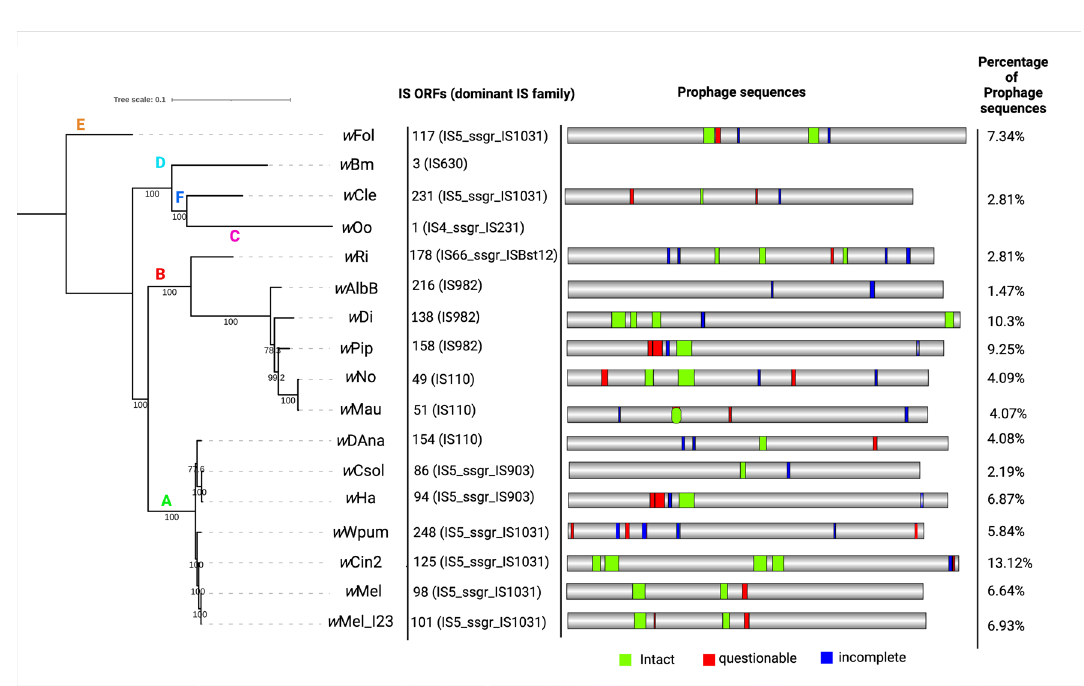
Figure 5. Phylogeny of complete genomes of Wolbachia strains belonging to supergroup A-F and schematic representation of their corresponding Insertion (IS) and prophage sequences. The maximum likelihood tree was constructed based on hmm source of single copy genes by Campbell et al. 65 proteins using IQ-TREE v 1.6.8 and the amino acid substitution model HIVb + F + I + G4, and wFol was set as the